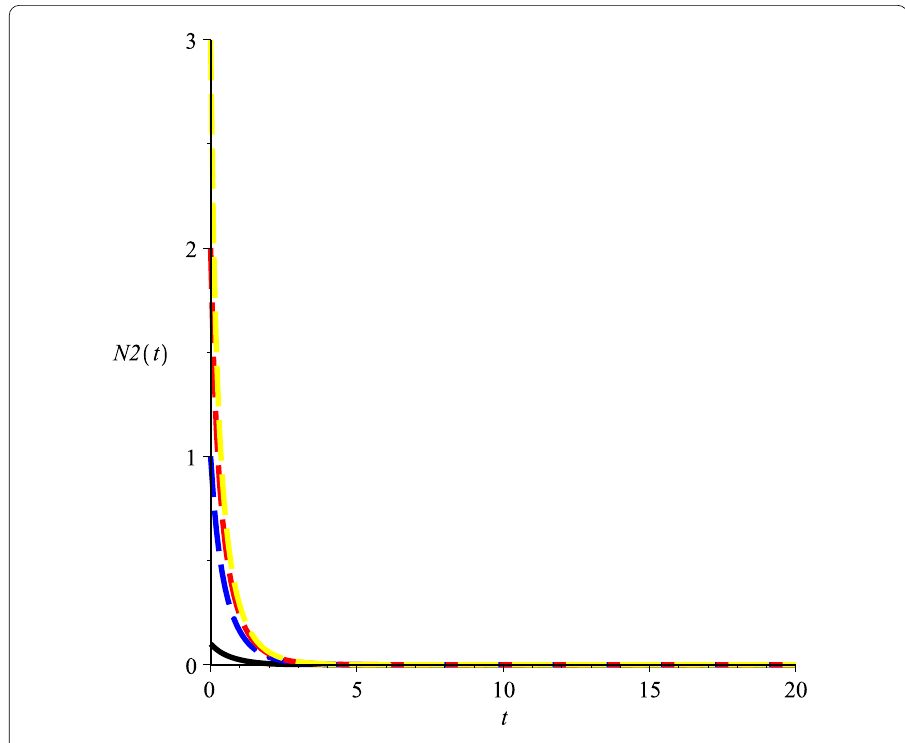
Figure 4 Numeric simulations of the second components of system (5.1) with m = 0.6, the initial conditions ( x (0), y (0)) = (0.5,0.1),(0.8,1),(0.3,3), and (0.7,2), respectively